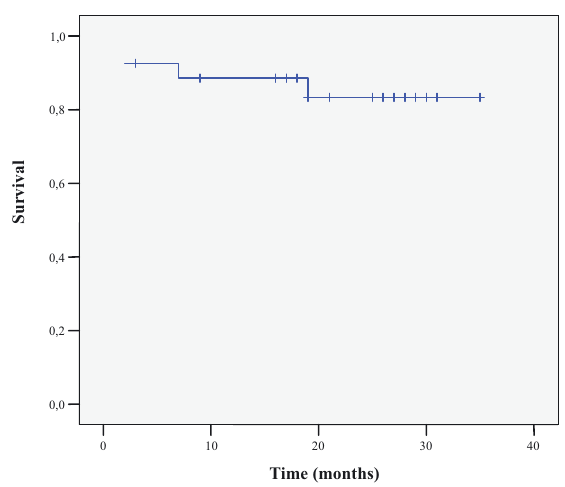
Figure 1. Kaplan-Meier analysis of cancer specific survival.